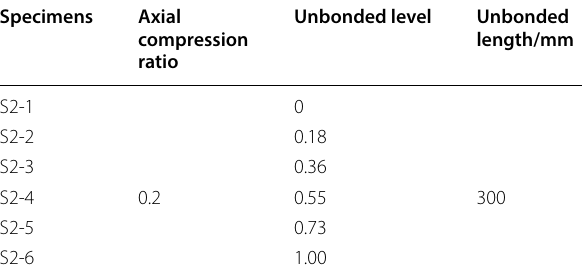
Table 10 Simulated variable parameters of unbonded